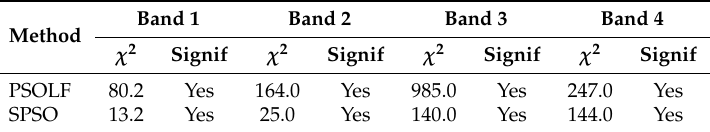
Table 8. Statistical significance of improvement of accuracy of the proposed algorithm LIPSO using McNemar’s Test [52] on Malambuzha Dataset. χ 2 values with one degree of freedom and 95% confidence, p < 0.05, (Signif = significance).